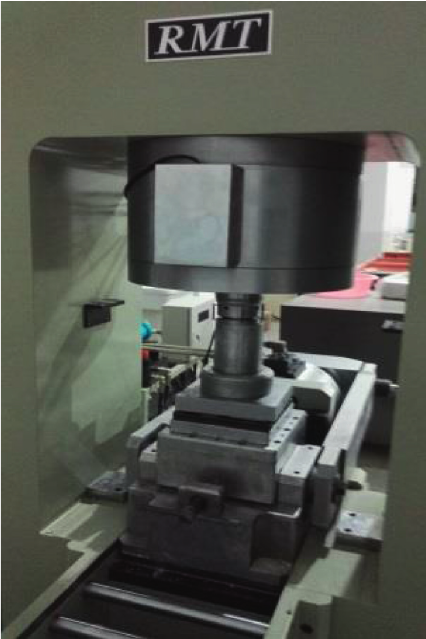
Figure 5: RMT-301 mechanics test system for rock and concrete.